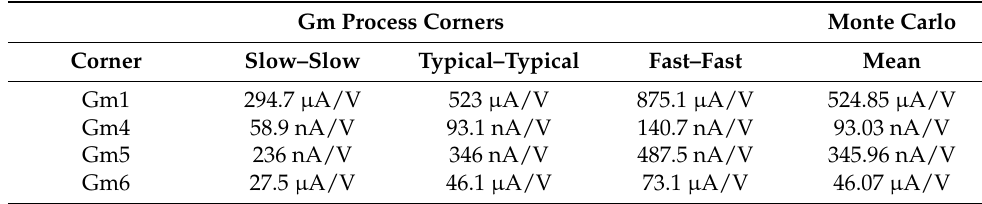
Table 14. Behavior of Gm in process corners.